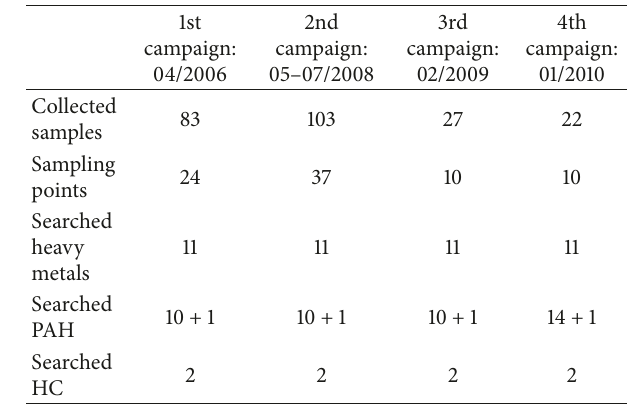
Table 1: Scheme of the monitoring campaigns.